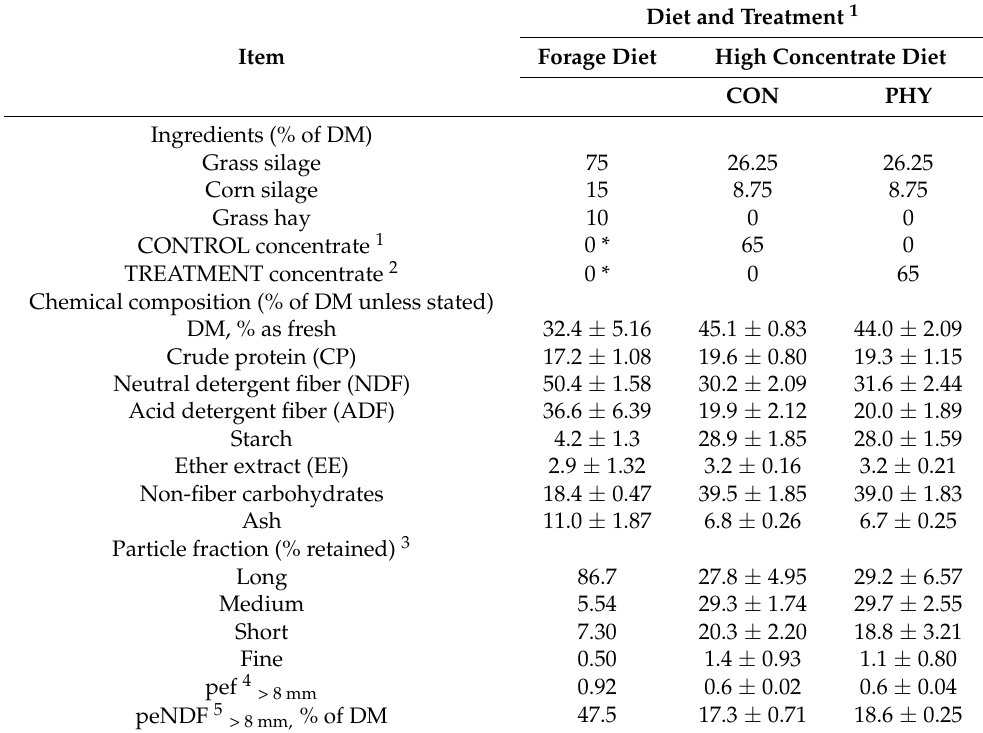
Table 1. Ingredients, chemical composition, particle size distribution of diets fed to cows during the week of forage feeding and the high concentrate feeding period. Diet and Treatment 1 Forage Item